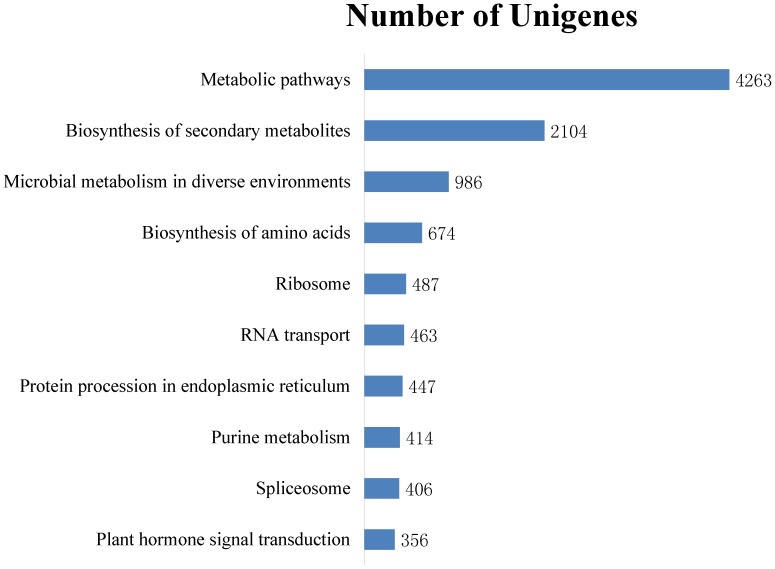
Top ten of unigenes in the Pathway assignment based on the Kyoto Encyclopedia of Genes and Genomes (KEGG).